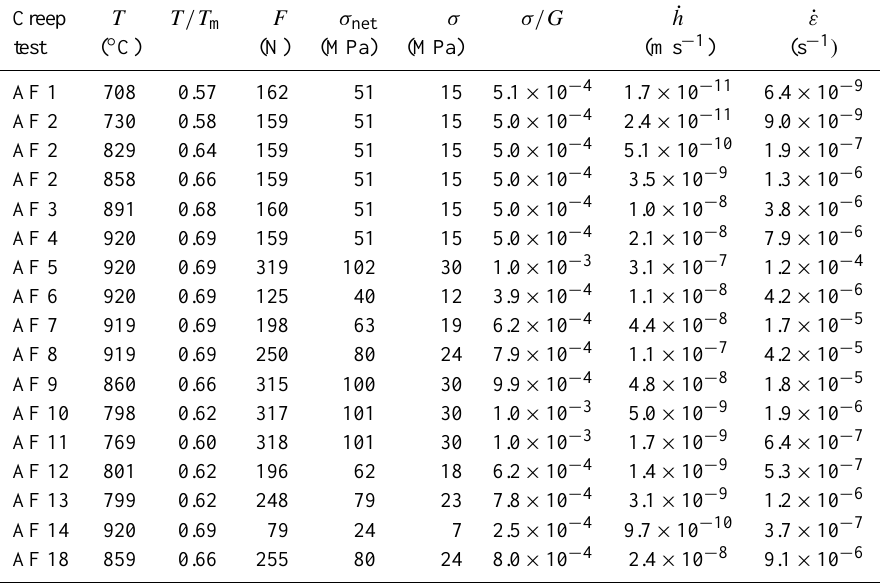
Table 1. Indentation creep data for polycrystalline anhydrite. For each creep test, the temperature T , the homologeous temperature T/T m , the load F , the net section stress σ net , the uniaxial reference stress σ , the normalized reference stress σ/G with shear modulus G , the indentation rate ˙ h , and the uniaxial reference strain rate ˙ ε rate are listed. Sample AF 2 was deformed at three different temperatures, while the load was kept constant.